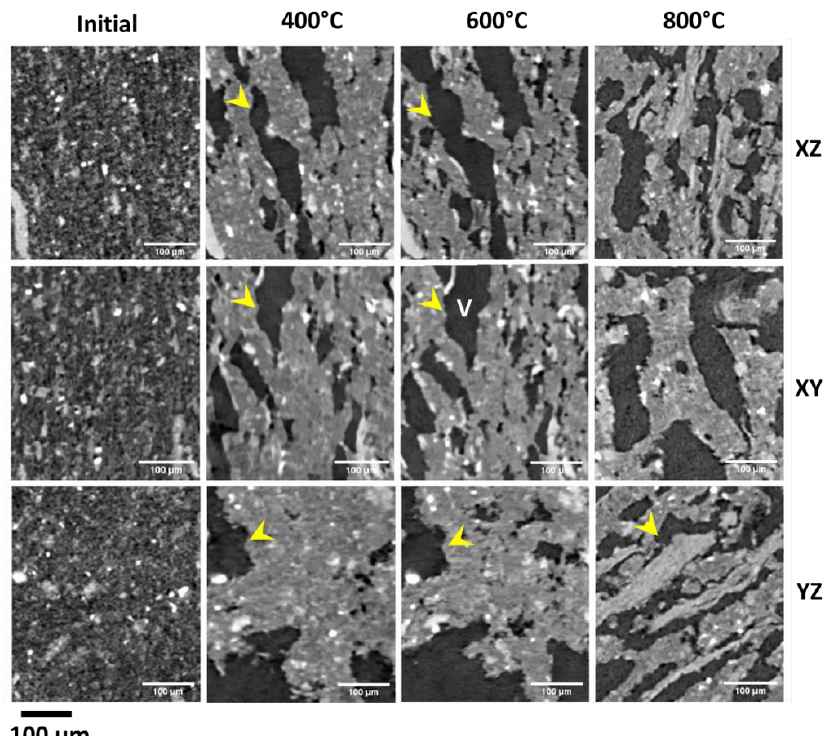
Figure 10. Micro-CT slices in XZ plane of Ch-46t sample before heating and after heating at 400 °C, 600 °C, and 800 °C ( XZ , XY , and YZ planes). Slices for the initial state and at 400 °C and 600 °C were selected for the same areas. Arrows indicate fractures.